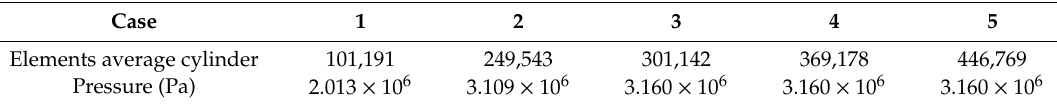
Table 3. Grid independence test.